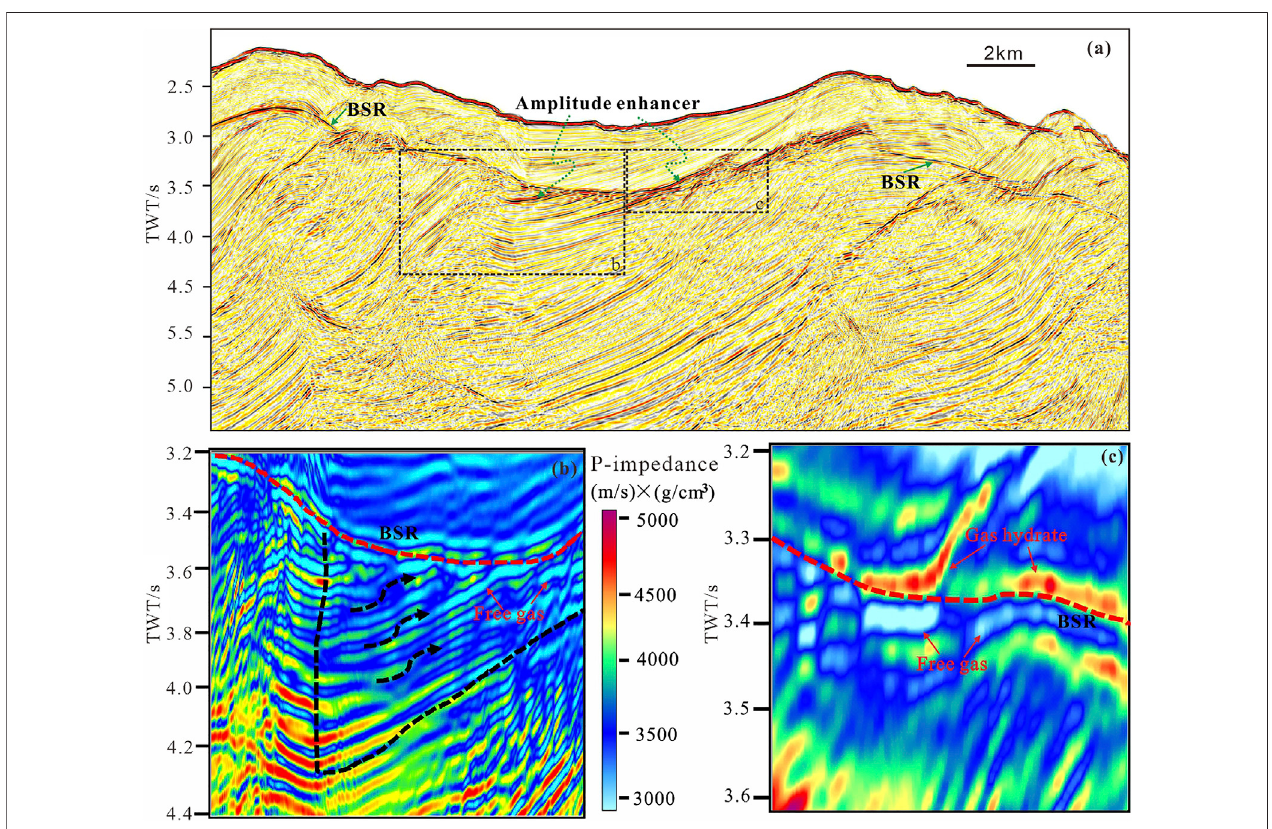
FIGURE5| Seismicpro fi le(timedomain)anddetailedviewsofimpedanceinversionresults(timedomain). (A) Seismicpro fi le; (B) impedanceinversionresultsofthe left part; (C) impedance inversion results of the right part.